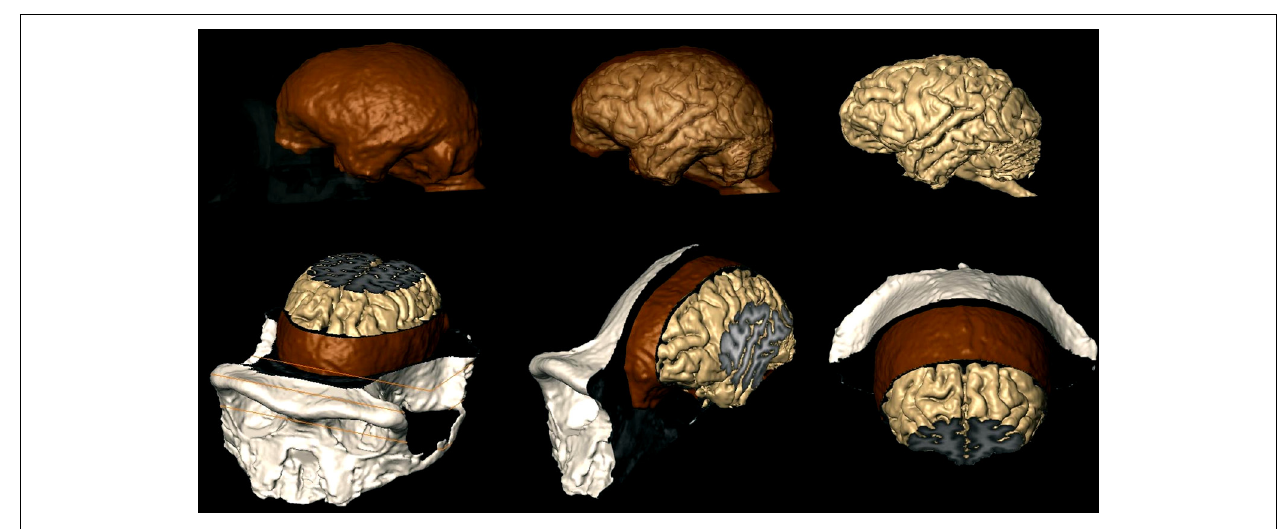
FIGURE 3 | MRI techniques used to study the brains of chimpanzees (Semendeferi etal., 2002), can now investigate the relationship between the brain and the endocast as shown here. Brain is beige; endocast is